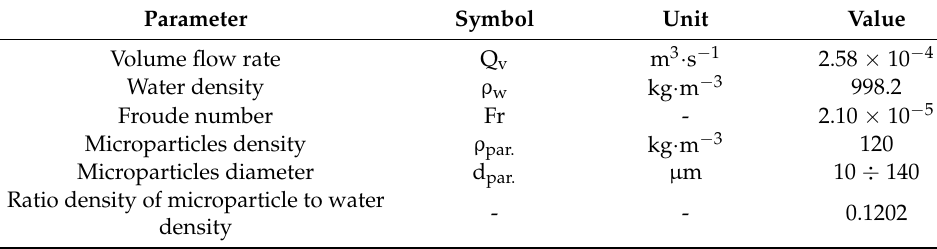
Table 3. Physical quantities—laboratory research. Parameter Symbol Unit Value Volume flow rate Q v Water